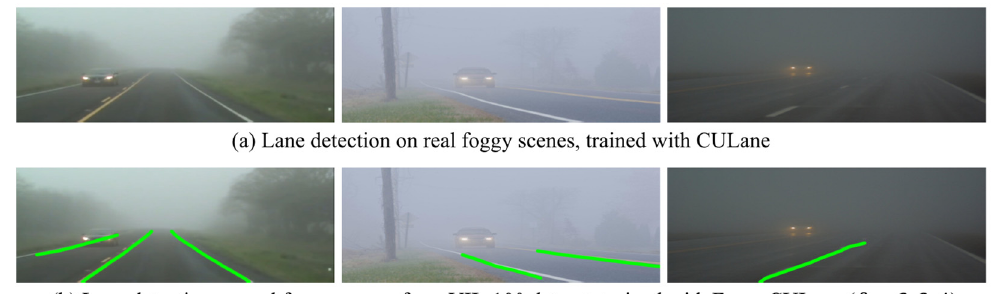
Figure 8. The lane detection results of SCNN tested in real foggy images acuiqred online without labelling: the first row shows the results of SCNN trained on CULane and the second row shows the results of SCNN trained on FoggyCULane. Green lines denote detected lane markings by the model.